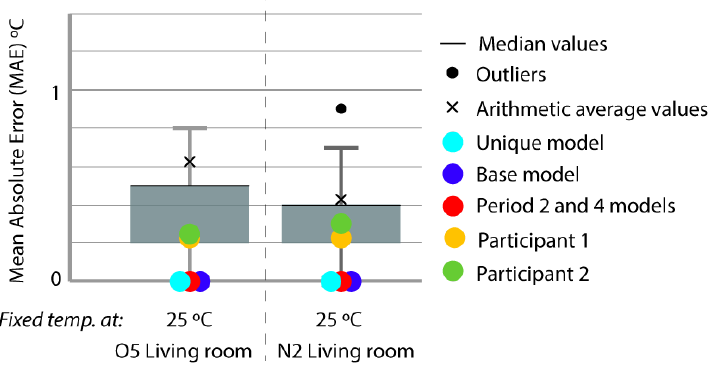
Figure 12. Temperature MAE for Period 4 (fixed set point at 25 ◦